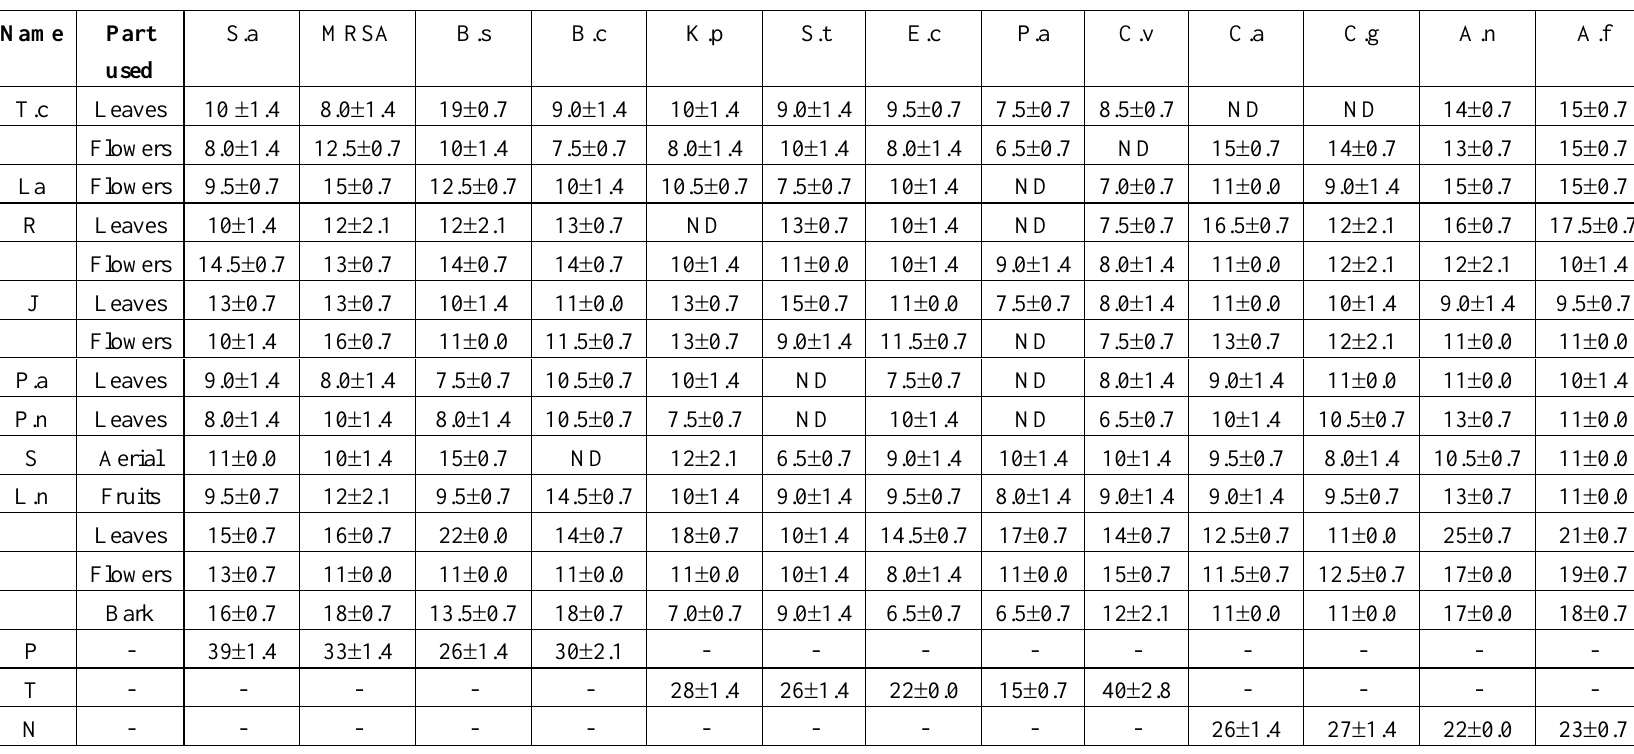
Table 2. Antimicrobial activity (mm inhibition zones diameter) of the ethanol plants extracts at 3